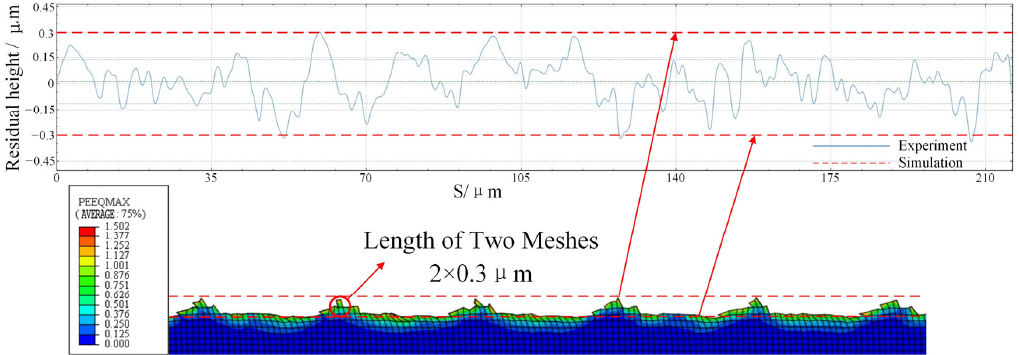
Figure 7. Comparison of machining residual height between experiment and simulation.